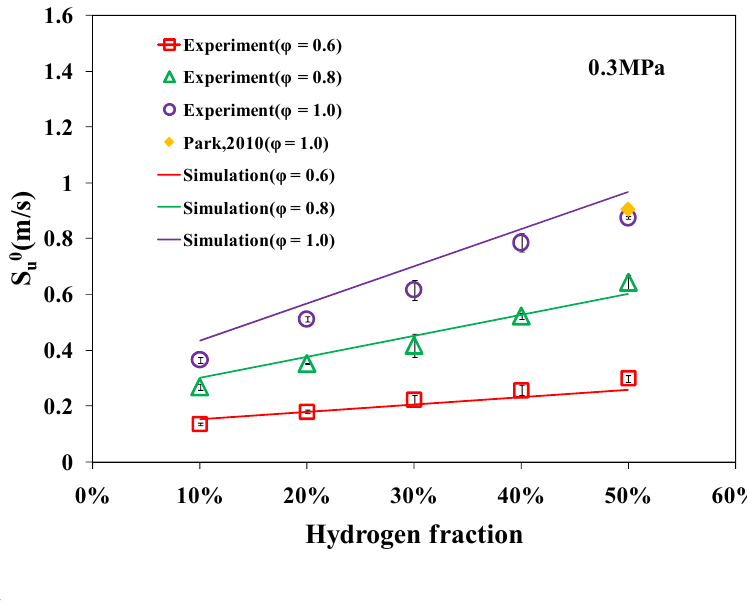
/CO mixtures at P 2